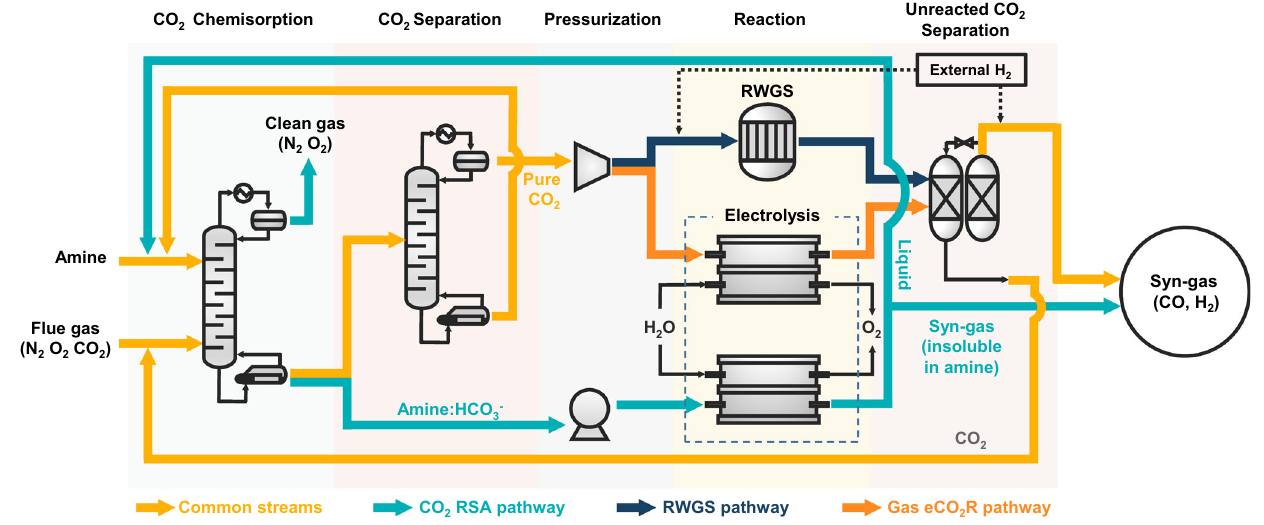
Fig. 1 | Schematic diagram comparing the RSA pathway with other CCU path- ways. Graphicalrepresentationofthereactionswingabsorptionprocess.Thelight blue stream represents the RSA pathway. Compared to the RWGS (dark blue) and